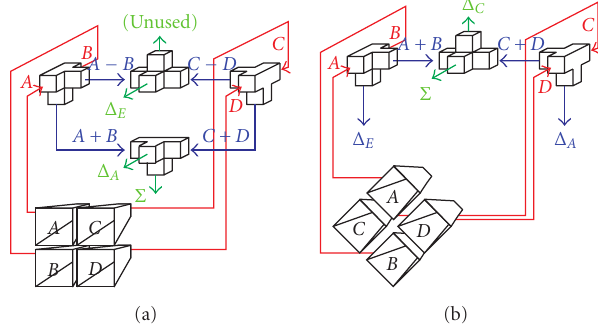
Figure 4: Comparator networks for the standard monopulse (a) and the crossfeed monopulse (b). In both images primary channels are in red, while first stage elaborations in blue and final outputs in green. The crossfeed setup is simpler not only because it has one less magic-T but also because two outputs are immediately available after the first